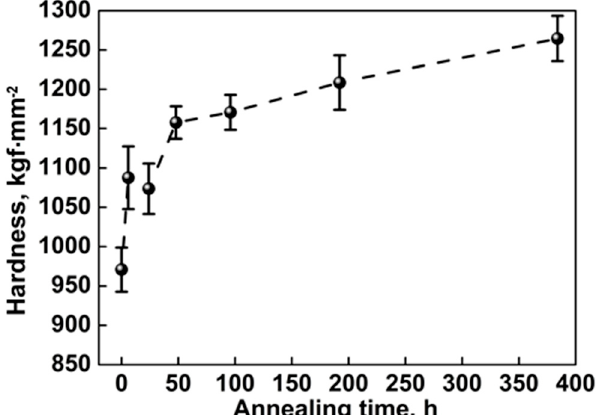
Figure 6. Surface hardness of the as-sprayed and the annealed coatings measured at RT.